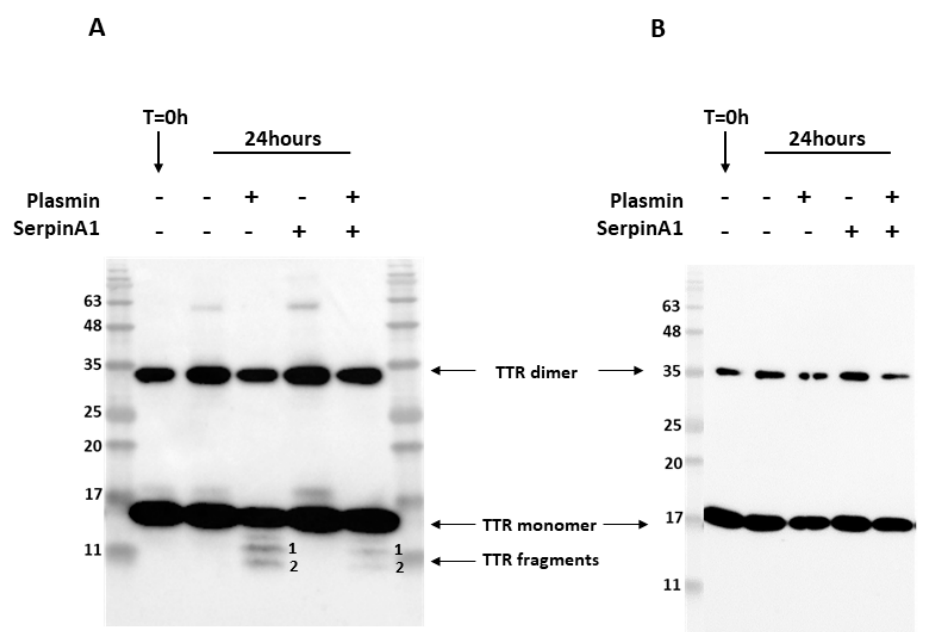
Figure 1. Plasmin cleaves transthyretin V30M, and its activity is inhibited by SerpinA1. Representa- tive images of Western blotting analysis of the three independent in vitro experiments. Western blot was performed using two different antibodies targeting human TTR, mouse anti-TTR mutant (Y78F), clone AD7 ( A ), and rabbit anti-transthyretin ( B ). Both antibodies detected dimeric and monomeric TTR forms. However, only the mouse anti-TTR mutant (Y78F) clone AD7 detects TTR fragments ( A ).